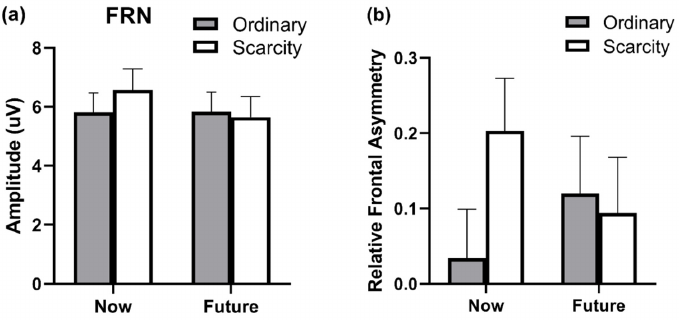
Figure 4. Panel ( a ) shows the mean amplitude values (uV) averaged over five electrodes (Fz, FC3, FCz, FC4, and Cz) across four types of conditions. Panel ( b ) shows frontal alpha asymmetry. The alpha power in the phase of feedback was extracted, and natural log transformation was performed. Then, asymmetry was calculated by subtracting power at the left electrode (F3) from power at the right electrode (F4). Error bars indicate one standard error.